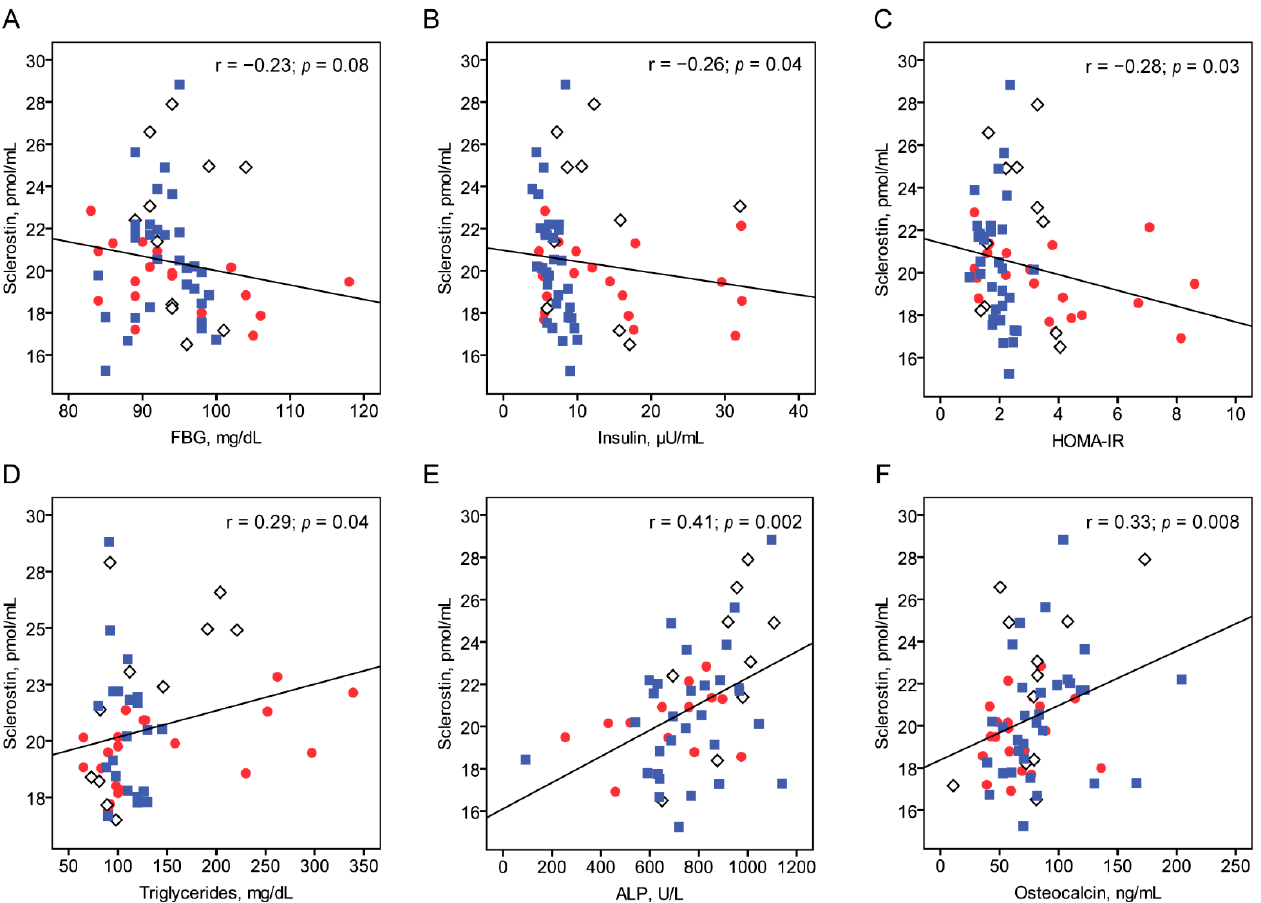
Figure 1. Correlations between serum sclerostin levels and FBG ( A ), insulin ( B ), HOMA–IR ( C ), TG ( D ), ALP ( E ), and osteocalcin ( F ). FBG, fasting blood glucose; HOMA–IR, homeostasis model assessment–insulin resistance; ALP, alkaline phosphatase. Red closed circles, open diamonds, and blue closed rectangles indicate the data for obese, overweight, and control groups, respectively.